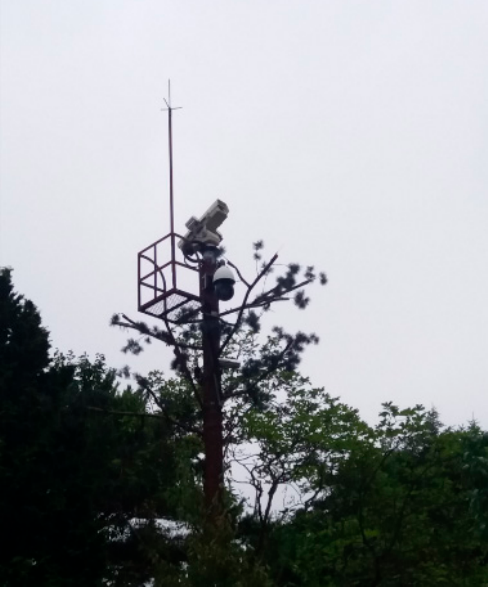
Figure 2. The power-line communication (PLC)-based lightning rod and intelligent closed-circuit television (CCTV) system installed at Beomeosa Temple (Geumjeong Mountain, Republic of Korea (ROK)) for a test bed experiment.